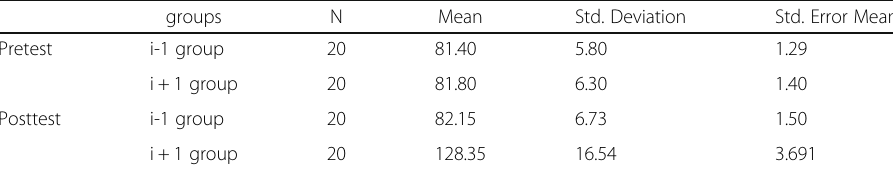
Table 6 Descriptive Statistics (Questionnaire of Both Groups before and after the Treatment) groups N Mean Std. Deviation Std. Error